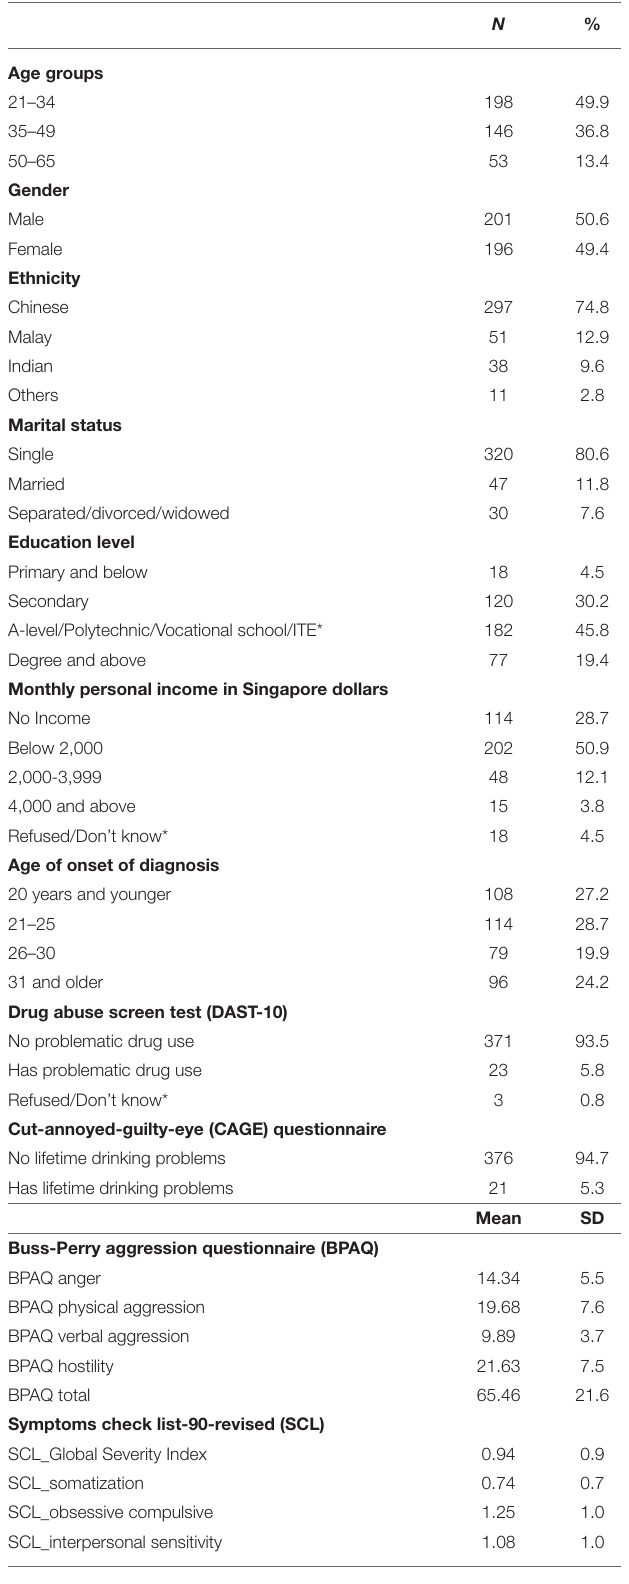
TABLE 1 | Socio-demographic and clinical characteristics of sample ( n =